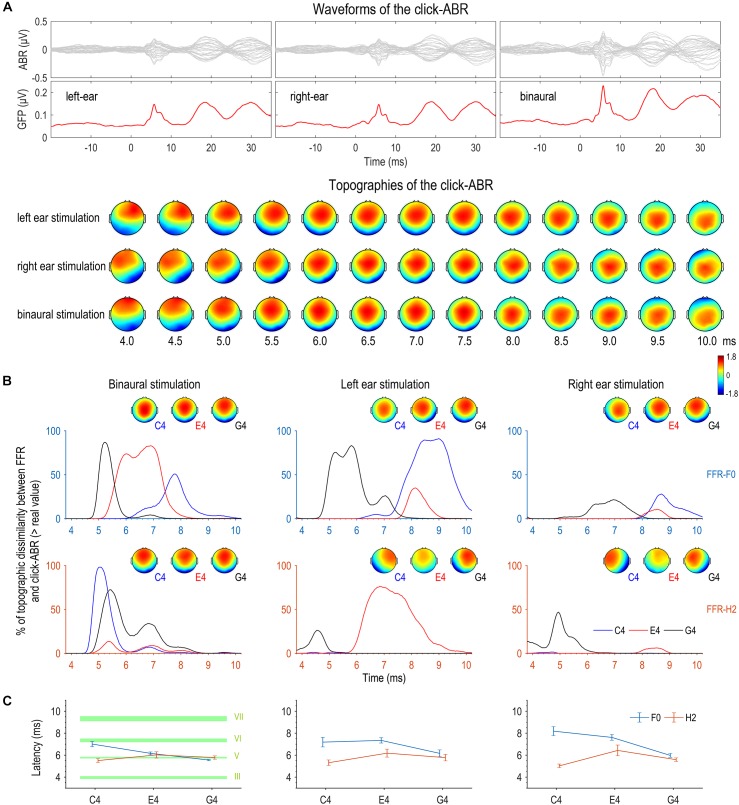
Topographic comparison between FFR and click-ABR. (A) Auditory brainstem responses (ABRs) were evoked by clicks with a comparable level to the complex tones used to evoke FFRs. Displayed here are the grand averaged waveforms of the click-ABR across channels, the global field power (GFP) of the click-ABR, and the topographies of the click-ABR as a function of time. Note that the topographies at later latencies correspond to neural activity at higher levels. (B) For the F0 component, the bootstrap-based similarity statistic reaches its peak first for G4, later for E4, and latest for C4. For the H2 component, the similarity peaks appear at similar latencies for the three tones in binaural conditions; in monaural conditions, the topographic similarity between the FFR to C4 and the click-ABR is poor within the entire time range corresponding to brainstem origins. (C) The results of the topographic similarity statistic and those of individual latencies based on topographic correlations are highly consistent for the F0 and H2 components in binaural conditions. The F0 component of binaural FFRs to a higher stimulus F0 shows the greatest topographic resemblance to the click-ABR at an earlier latency, whereas the H2 component of binaural FFRs to different stimulus F0s shows the greatest topographic resemblance to the click-ABR at similar latencies. Specifically, for the F0 component of the FFR, the latency for C4 is comparable to that of wave VI (generation site: inferior colliculus, IC), the latency for E4 is comparable to that of wave V (superior olive complex, SOC; and/or lateral lemniscus, LL), and the latency for G4 is earlier than that of wave V but later than that of wave III (cochlear nucleus, CN). For the H2 component of the FFR, the latency is comparable to that of wave V (SOC and/or LL) for all three tones. Error bars refer to ±SEM. The upper and lower limits of green shaded rectangles refer to mean ± SEM.